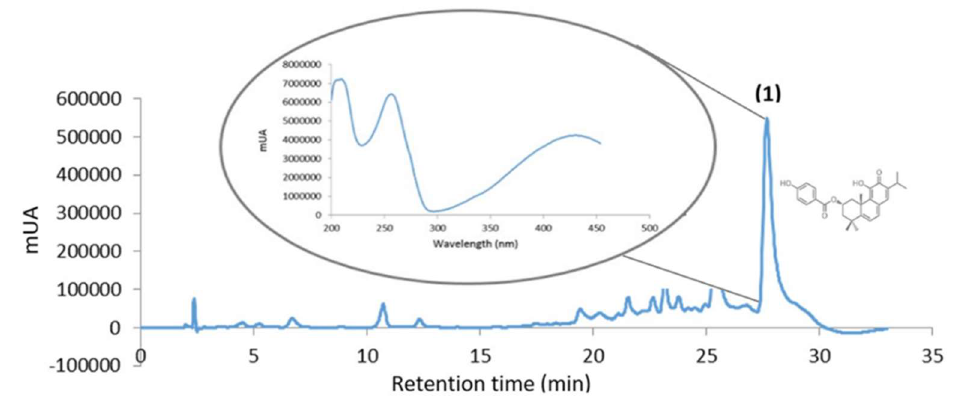
Figure 3. HPLC profile of P. ecklonii extract (254 nm): (1) Parvifloron D peak and absorption spectra.